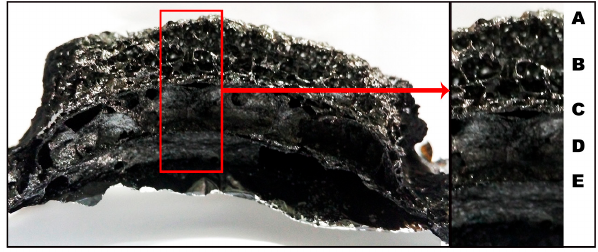
Figure 10. Digital photo of the interior part of EP-2 residual char after cone calorimeter test.